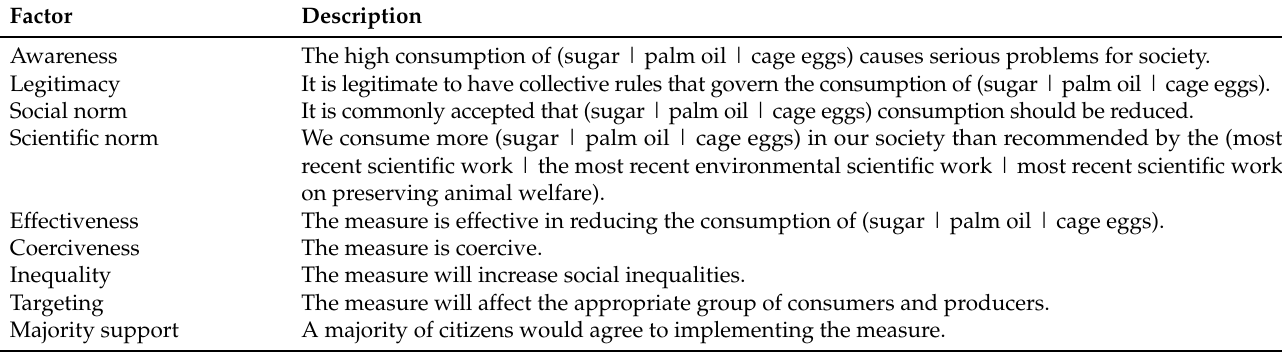
Table 1. Summary of